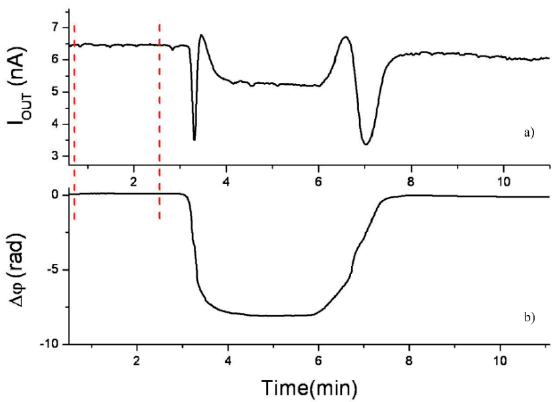
Figure 4. Response in a MZI sensor. ( a ) Standard interferometric signal; ( b ) Linear readout using a modulation system. Reprinted from [36] with permission of the Optical Society of America.